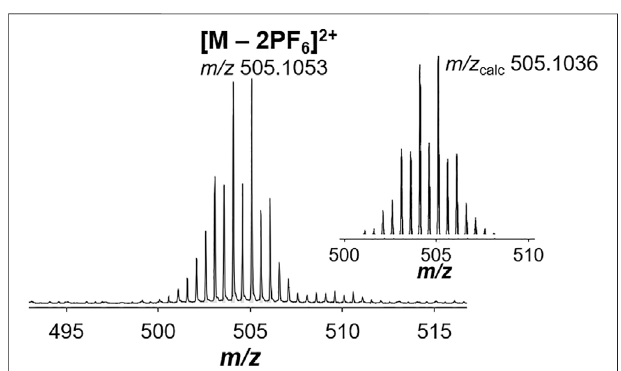
FIGURE 3 | ESI-mass spectrometry data for the Os-Ir complex 2f compared to the calculated isotope pattern for the [M – 2PF 6 ] 2+